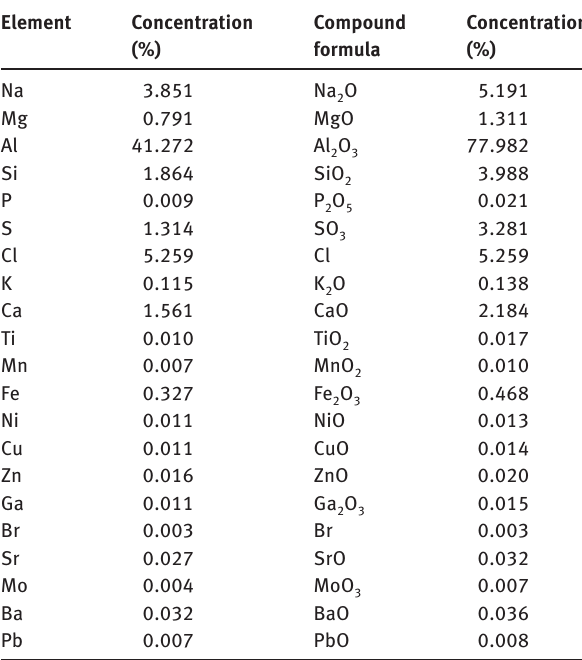
Table 1: Chemical composition of ECTW. Element